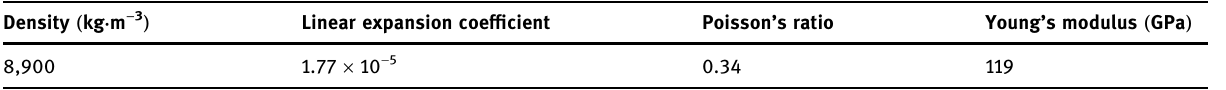
Table 3: Material properties